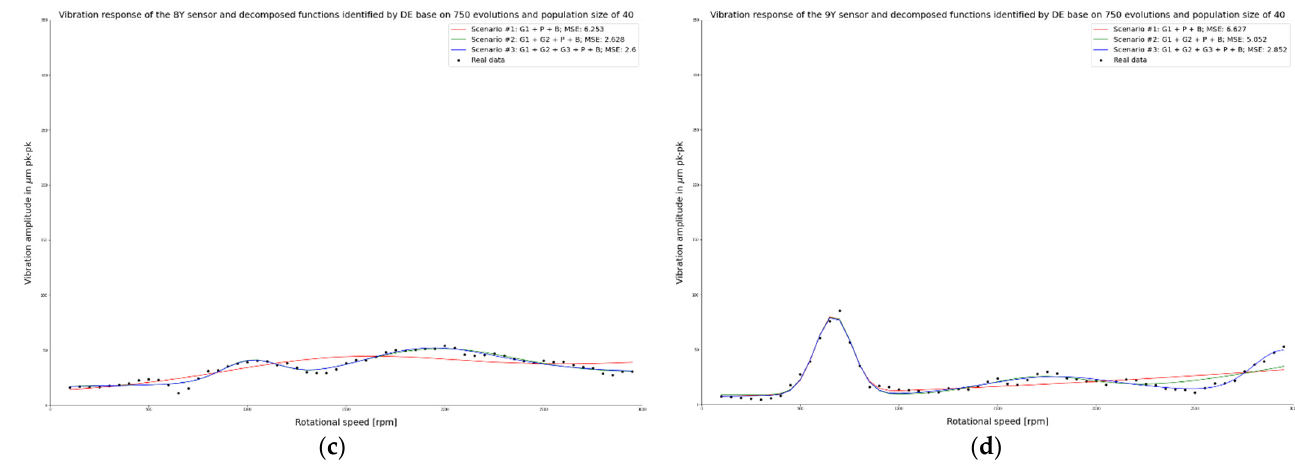
Figure 12. Decomposed function identified by the DE algorithm to fit data from a real object before and after balancing and the corresponding MSE indexes: ( a ) data from the bearing 8 and the sensor 8Y before balancing; ( b ) data from the bearing 9 and the sensor 9Y before balancing; ( c ) data from the bearing 8 and the sensor 8Y after balancing; ( d ) data from the bearing 9 and the sensor 9Y after balancing. Table 7. The MSE values based on the scenario and sensor location of the generator rotor with and without imbalance malfunction.